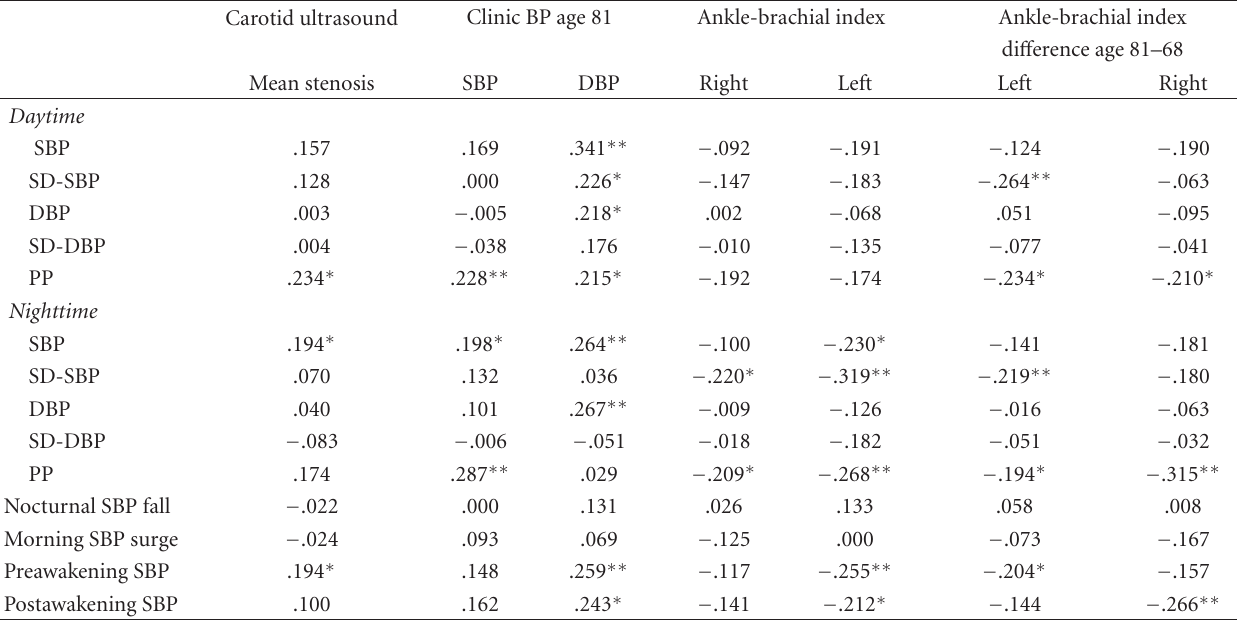
Table 5: Correlation coe ffi cients calculated for ambulatory blood pressure at age 82 and clinic blood pressure as well as for markers of vascular disease at age 81 (ABI: ankle-brachial index, ABI progression, and carotid stenosis at ultrasound